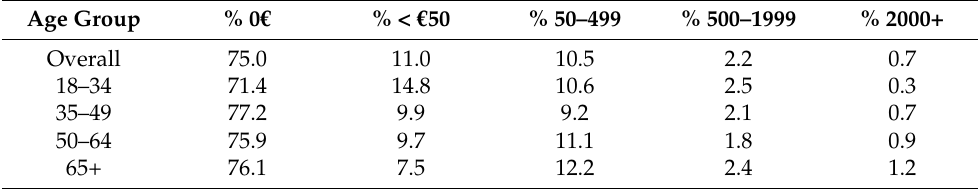
Table 5. Percentage of financial losses from online fraud in weighted sample.